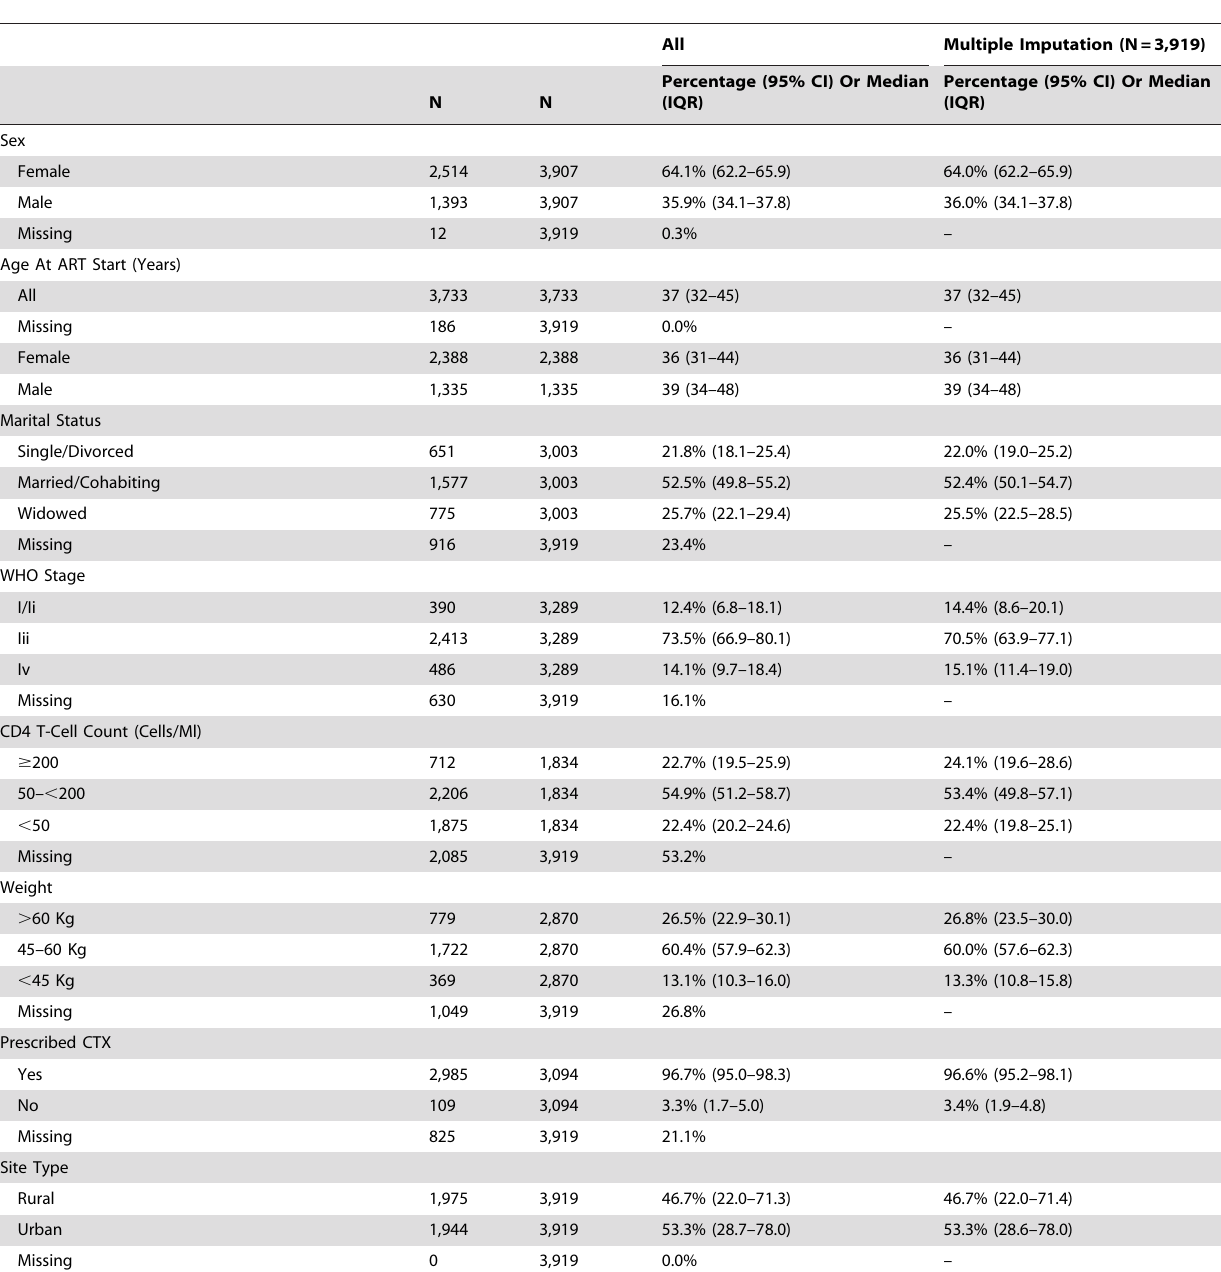
Table 1. Demographic and clinical characteristics of patients at ART initiation and characteristics of ART sites, including clinical